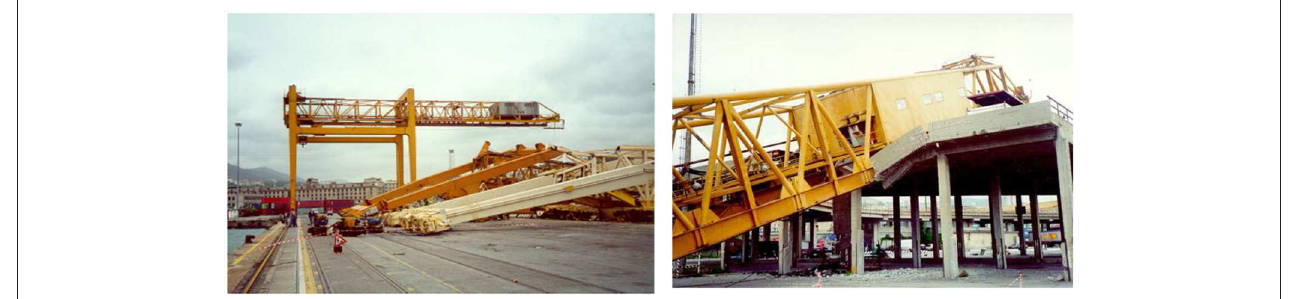
FIGURE 3 | Damage caused by a downburst in the seaport of Genova (August 31, 1994). speed (Gomes and Vickery, 1977/1978). This cannot be